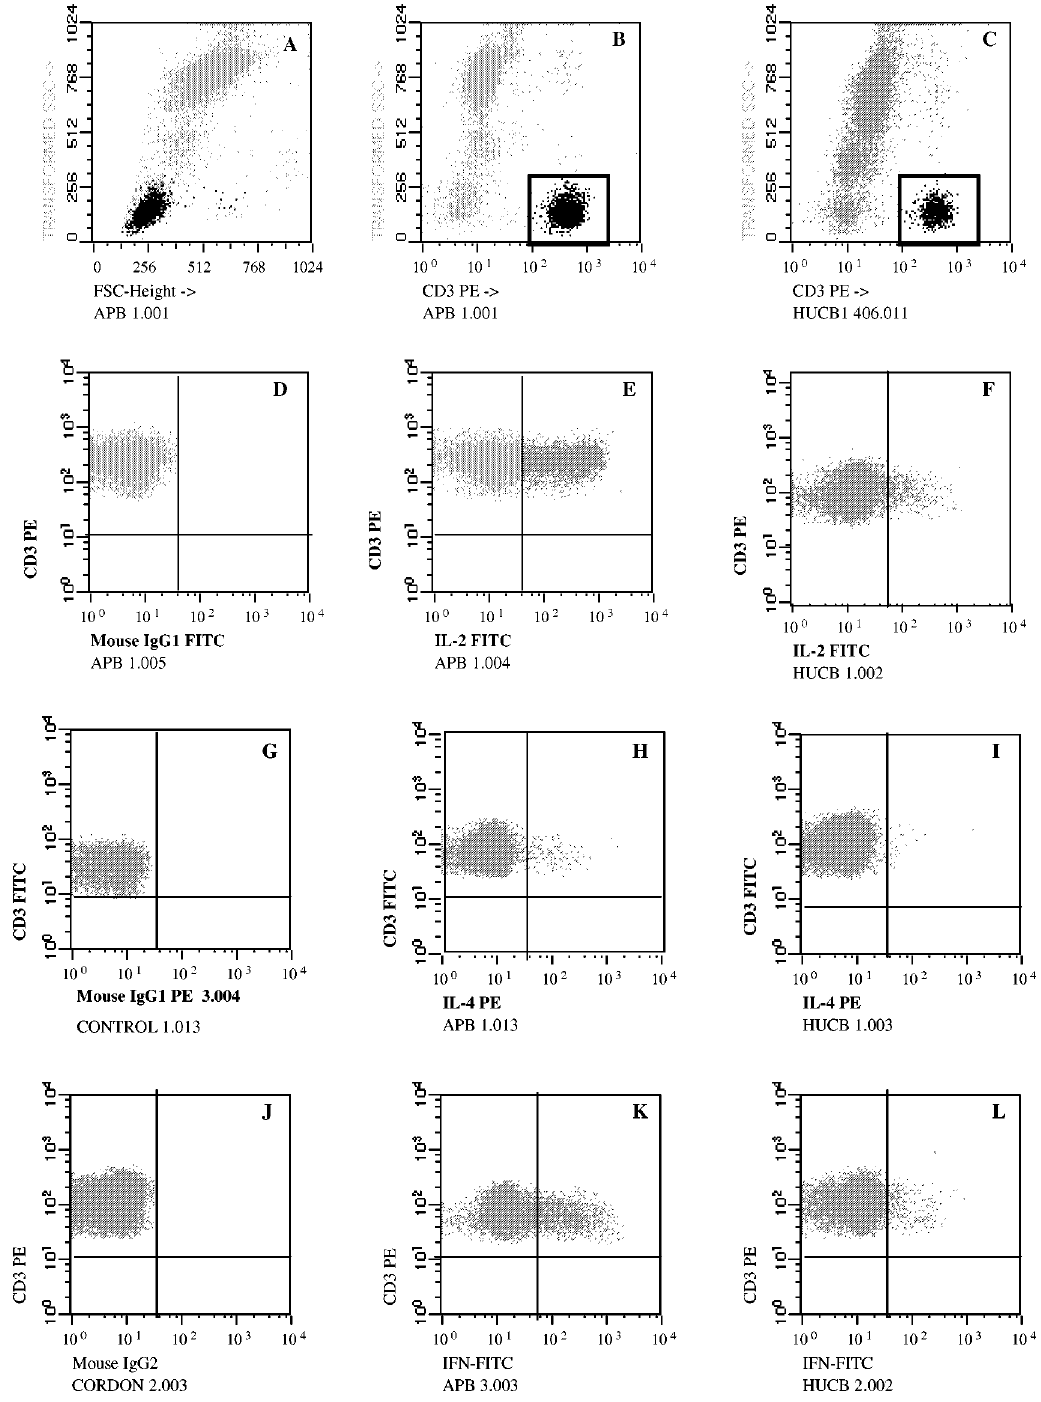
Fig. 1. Flow cytometric cytokine expression on HUCB and APBT lymphocytes. The top three dot plots (A, B and C) show the forward and transformed side scatter (SSC) distribution and the gate used to select T lymphocytes according to the expression of CD3 and low side scatter. The expression of Il-2 (E), Il-4 (H) and IFN- γ (K) on APB CD3 + lymphocytes is compared with the expression of Il-2 (F), Il-4 (I) and IFN- γ (L) on HUCB T lymphocytes. An isotype-specific negative control was used with each cytokine (D, G, and J,